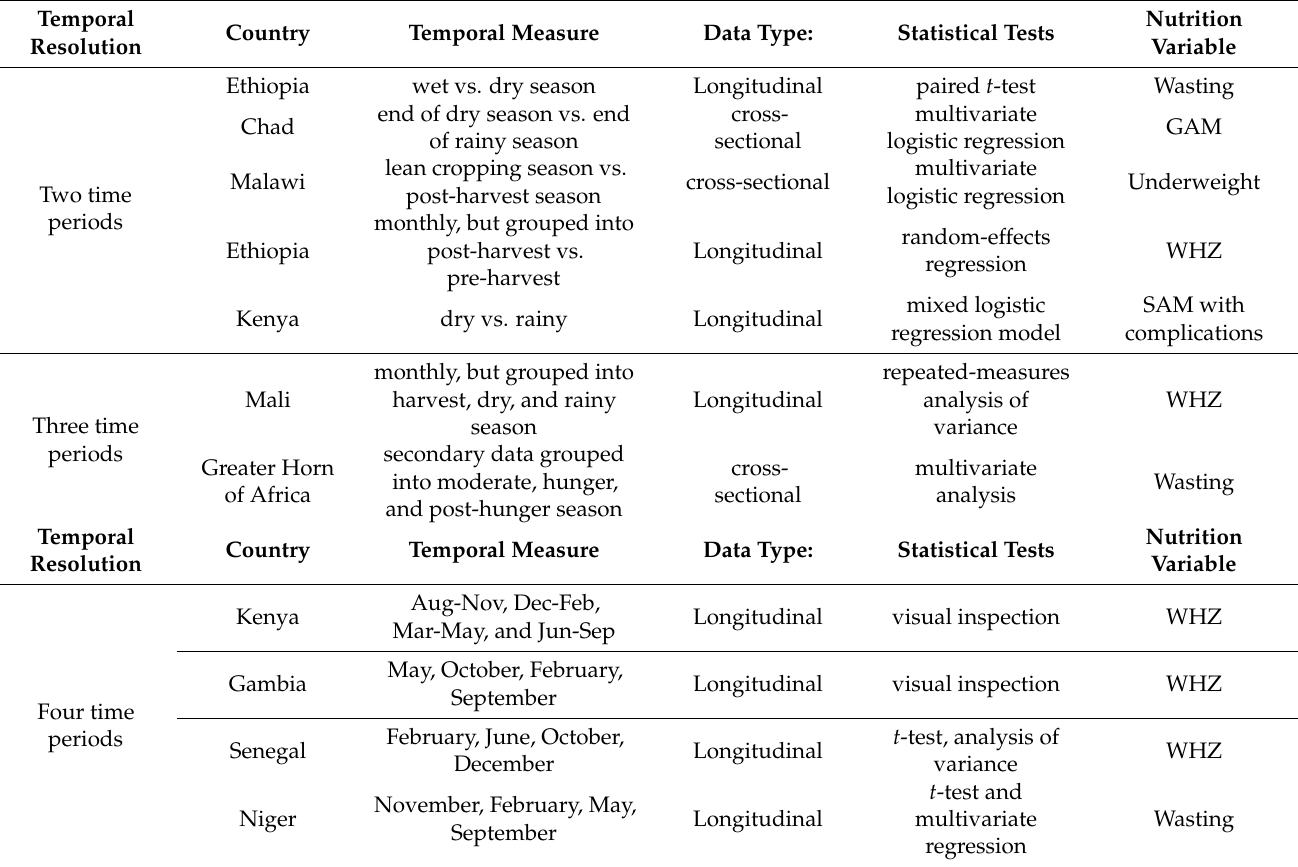
Table 1. Summary of temporal measures, data types, statistical tests, and seasonal nutrition variables presented in the reviewed